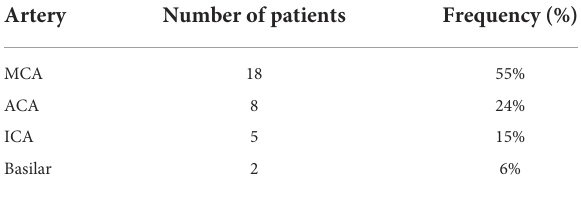
TABLE 3 Distribution of vessel occlusions in the study